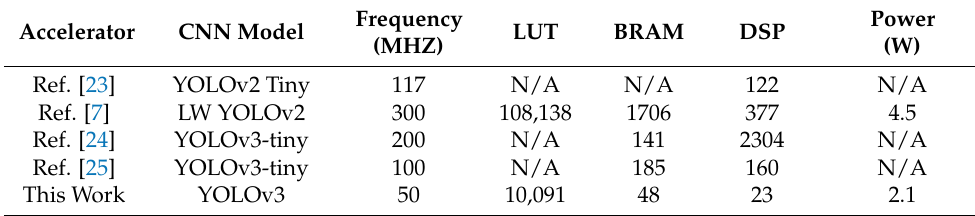
Table 6. Comparison with other FPGA accelerator